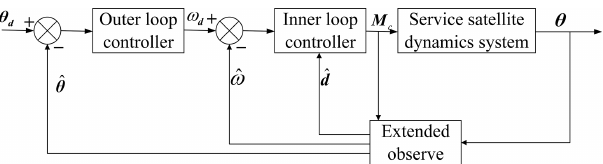
Figure 5. Spacecraft attitude double-loop sliding mode